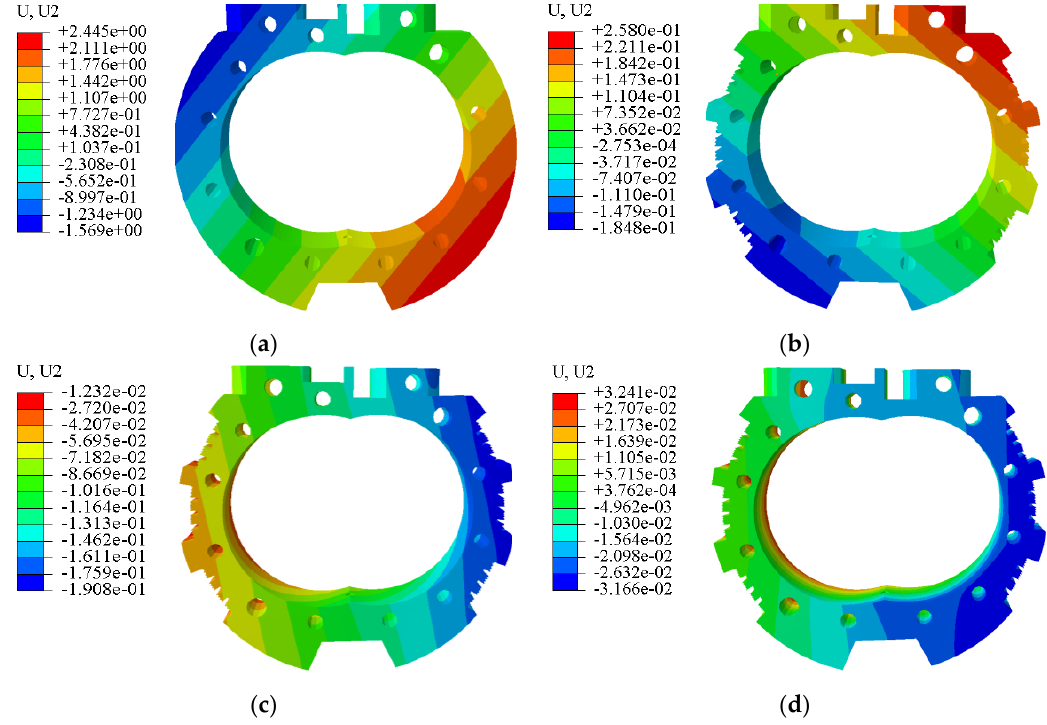
Figure 3. Deformation of the cylinder ( a ) without microtextures and with microtextures at different widths: ( b ) width = 100 μm, ( c ) width = 50 μm, ( d ) width = 20 μm.